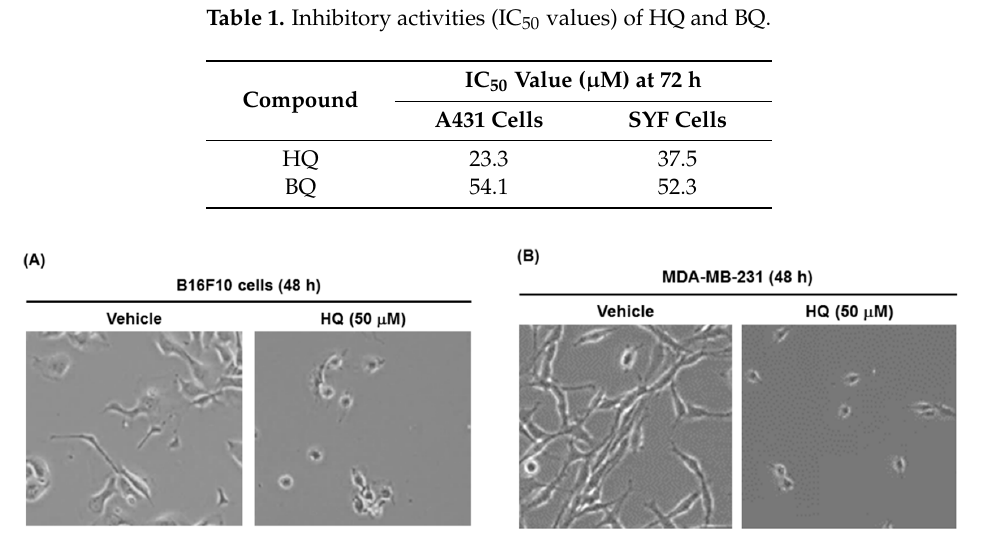
Figure 2. Effect of HQ on the morphological change of B16F10 and MDA-MB-231 cells ( A , B ) B16F10 cells and MDA-MB-231 cells were treated with either vehicle or HQ (50 μ M) for 48 h, and cell morphologies were photographed.